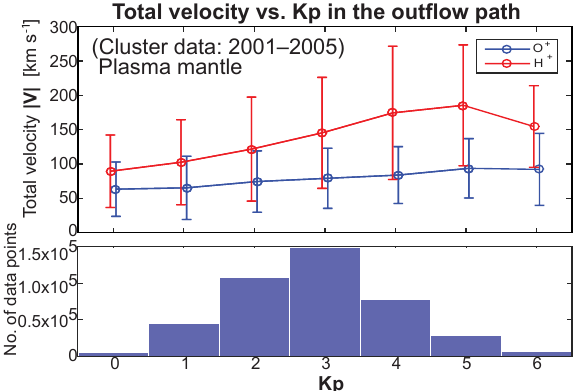
Total velocity vs. Kp in the outflow path